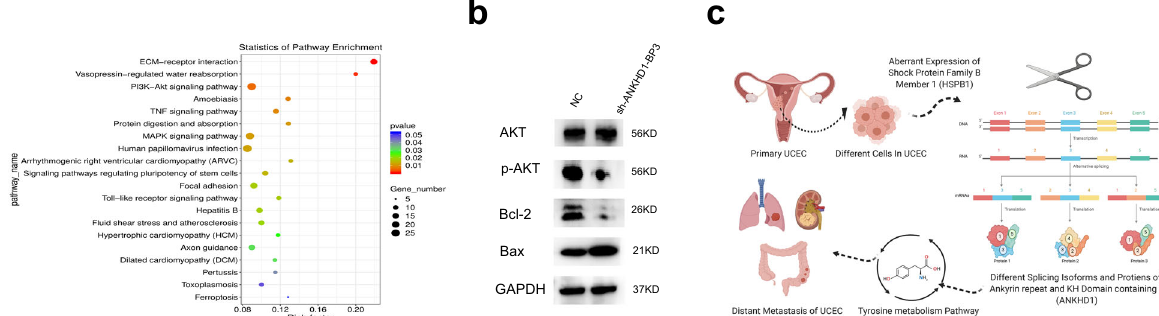
Fig. 8 ANKHD1-BP3 regulates the activity of the PI3K-AKT pathway and the plot of the hypothesis. Bubble maps ( a ) of the KEGG pathway. ANKHD1-BP3 regulates the activity of the PI3K-AKT pathway in Ishikawa ( b ). The plot of hypothesis ( c ) showed that HSPB1 regulated ANKHD1, and the transcript of ANKHD1 was involved in the tyrosine metabolism pathway, which affected the distant metastasis. Figure 8c was created with